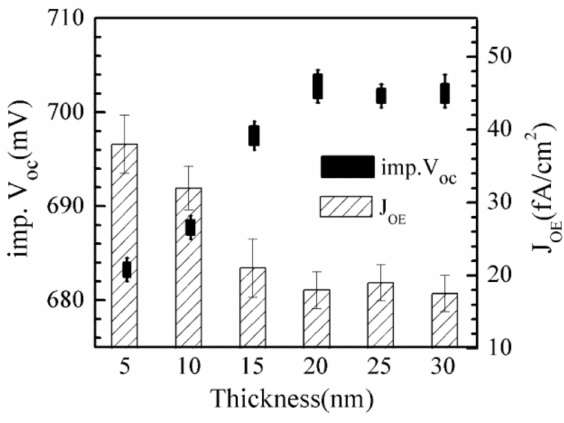
Figure 7. J 0 E and implied V oc change with SiO x :B